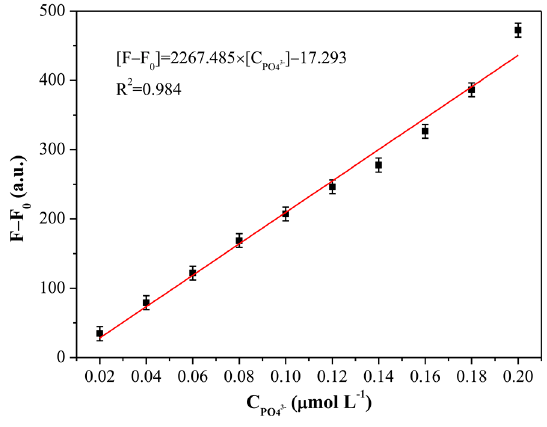
Figure 7. The linear relationship of F-F 0 versus the concentration of phosphate (0.02–0.20 µ mol · L − 1 ). PCDs, 0.02 mg · mL − 1 ; Eu 3 + , 30.0 µ mol · L − 1 ; Tris–HCl bu ff er, pH Table 1. A comparison of different systems for phosphate determination.